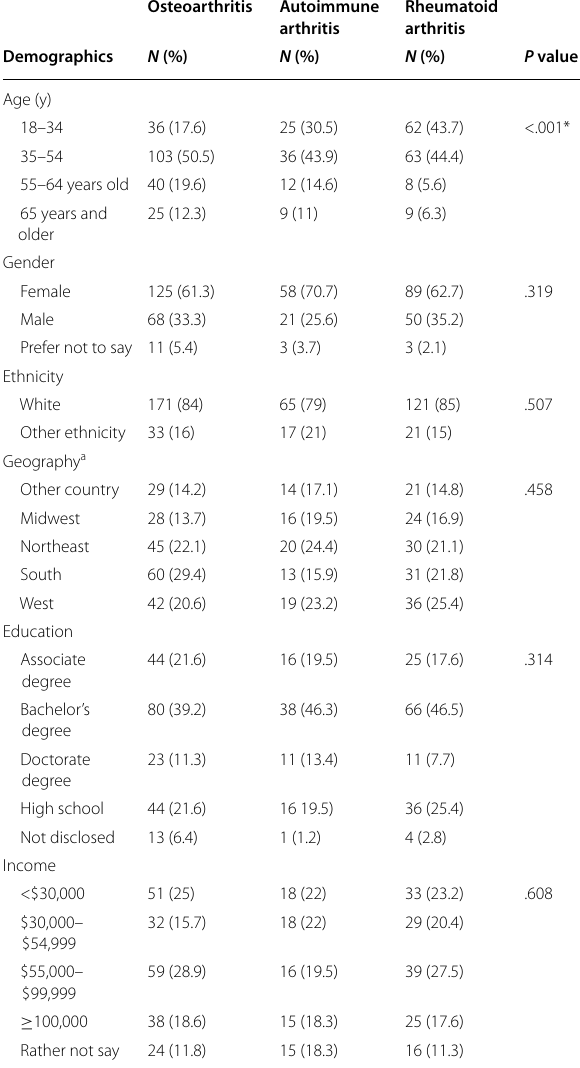
Table 2 Comparison of socioeconomic demographics and CBD utilization based on type of arthritis between group comparisons of participants by type of arthritis and patterns of CBD